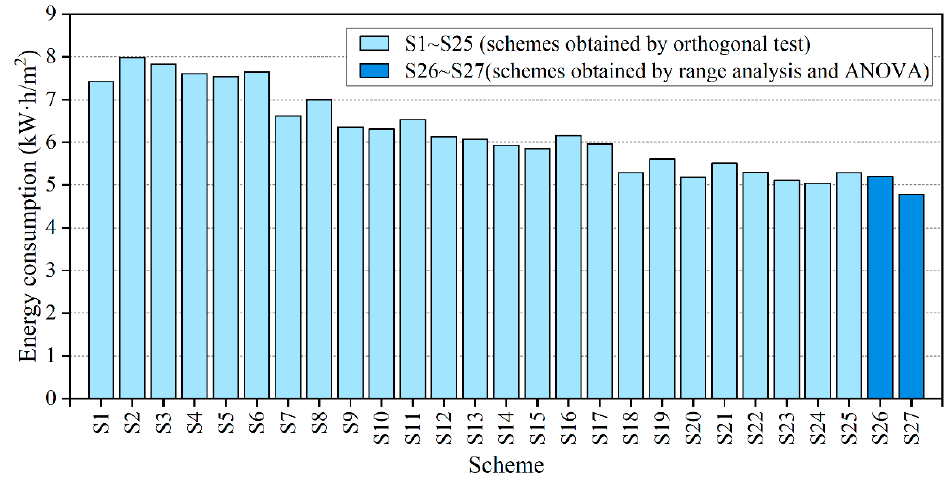
Figure 9. Room energy consumption per square meter, in January, of the 27 schemes.